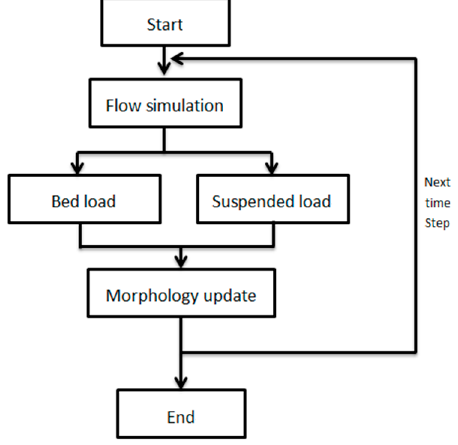
Figure 1. Flow chart of the local scour model.